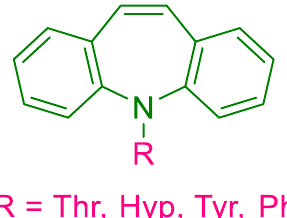
Figure 29. Amino acid conjugated to 5H-dibenz[ b , f ]azepine.